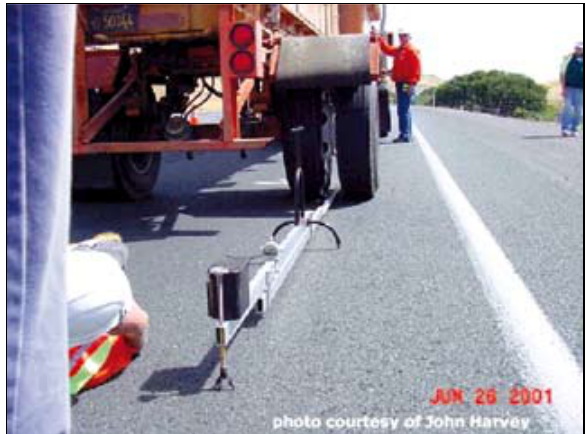
fig. 2. Benkelman Beam (Washington State Department of